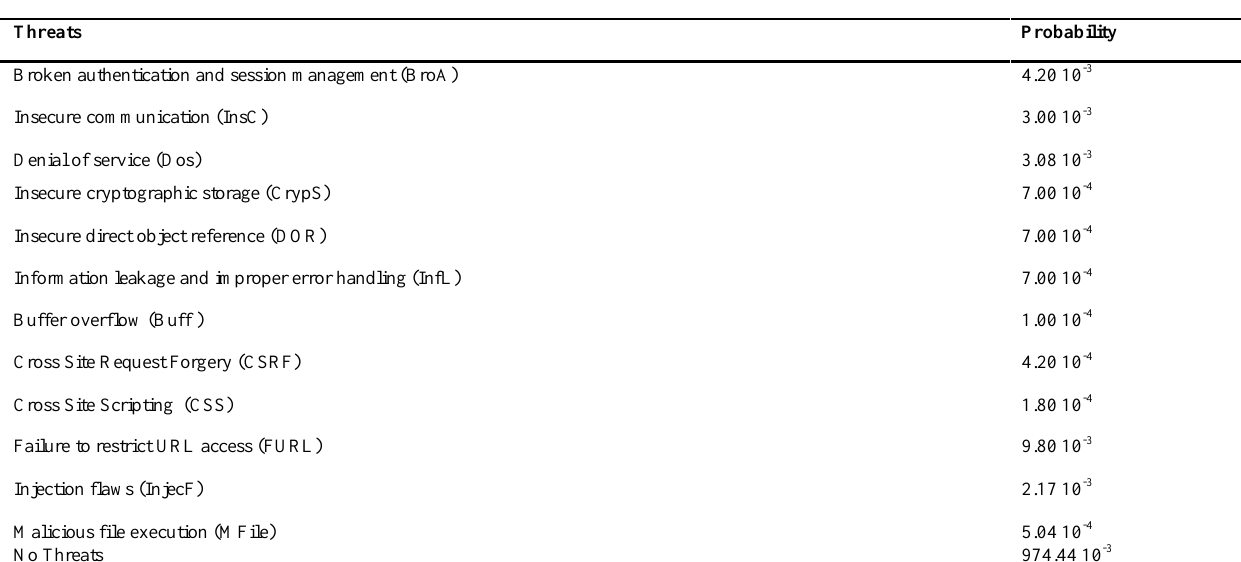
Table 5: The T Vector